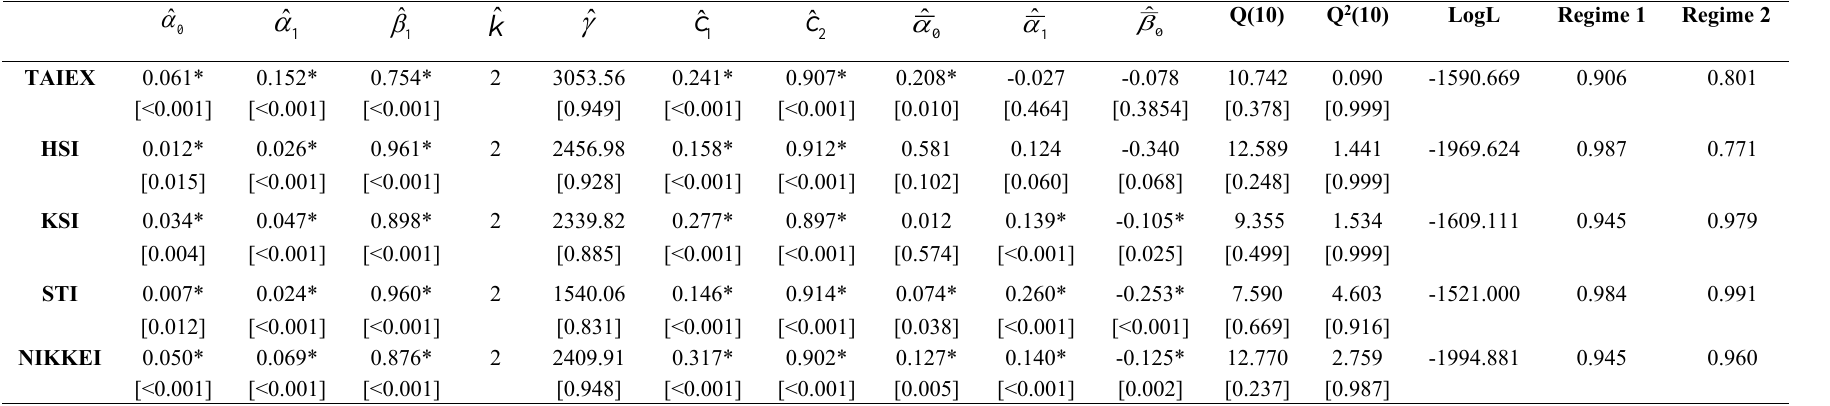
Table 4: The ST-GARCH model